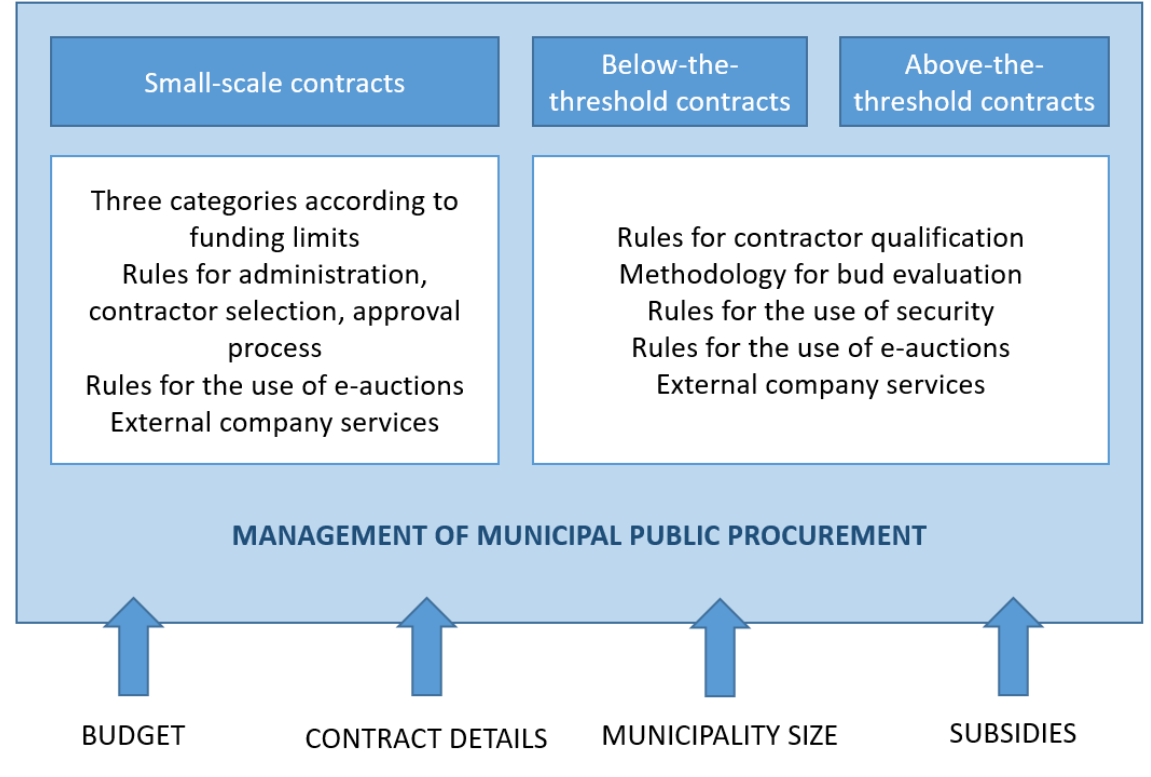
Figure 2: Selected aspects of public procurement